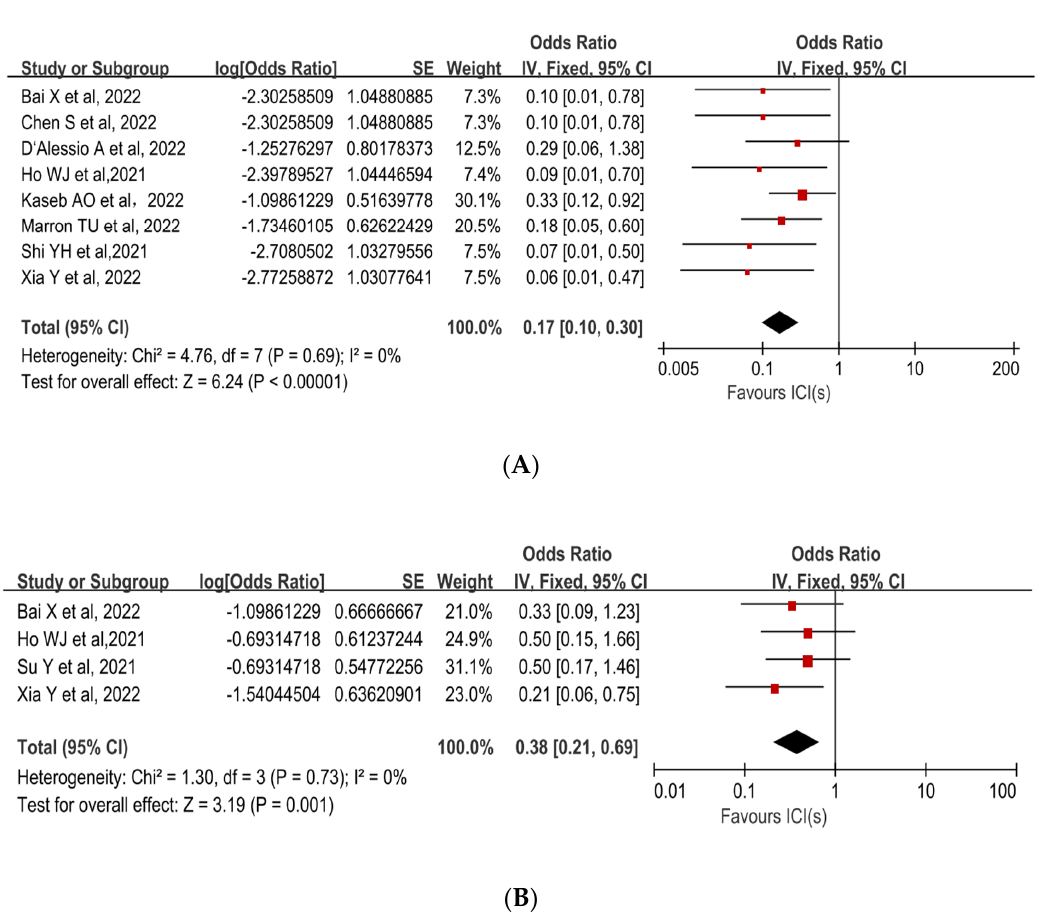
Figure 2. Forest plot of the efficacy of neoadjuvant immune checkpoint inhibitors in resectable hepa- tocellular carcinoma. ( A ) pCR, ( B ) MPR. pCR: pathological complete response; MPR: major patho- logical response [30–38].